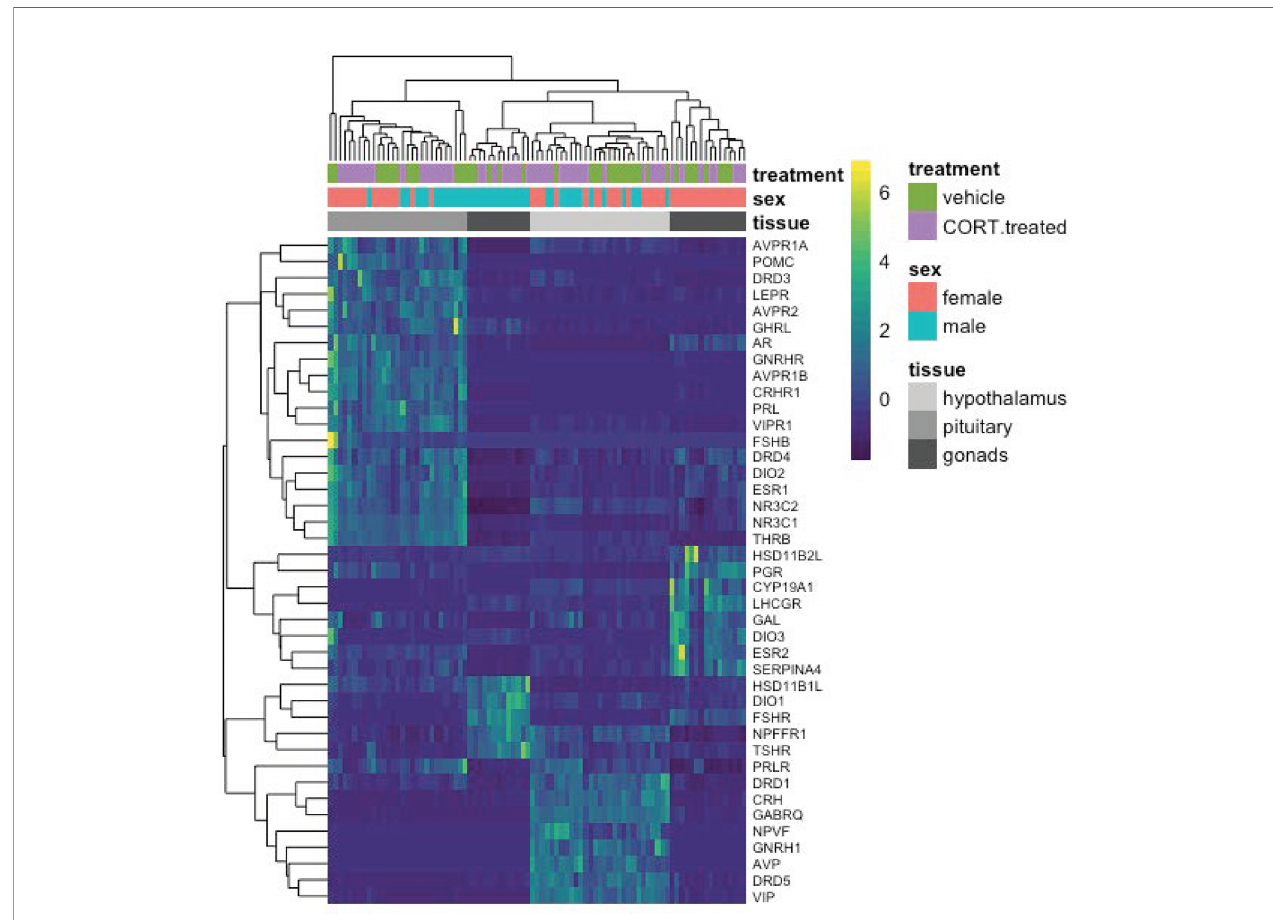
FIGURE 6 | A heatmap depicting individual candidate gene expression values (normalize gene counts) represented as colors. Blue shades signify low levels of expression; Yellow shades signify relatively higher levels of expression. The Y -axis on the right denotes the gene abbreviation; the Y -axis on the left is a dendrogram of expression similarity. The X -axis denotes the sex, tissue, and treatment group of the animal (CORT-treated or the vehicle